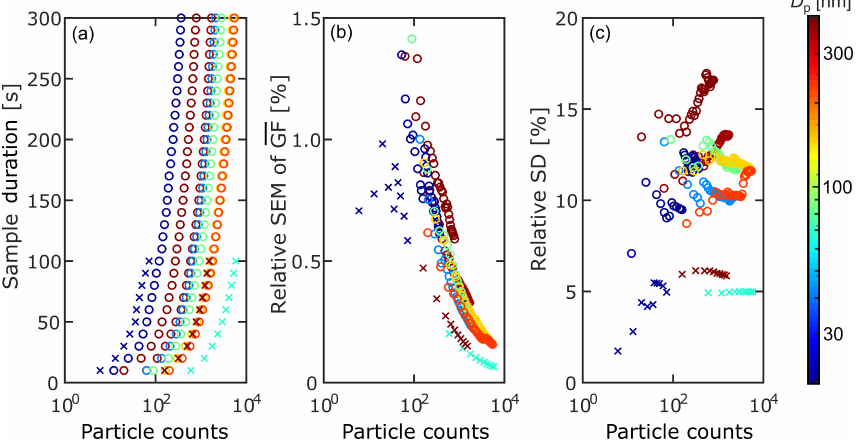
Figure 8. (a) Sample duration, (b) relative standard error (SEM) of the mean particle growth factor GF and (c) relative standard deviation (SD) of the sample particle size distribution as a function of total particle counts for the ambient aerosols sampled on 6 November (crosses) and 3 December (circles) 2015. Color coding represents mean particle wet sizes at RH = 85%.